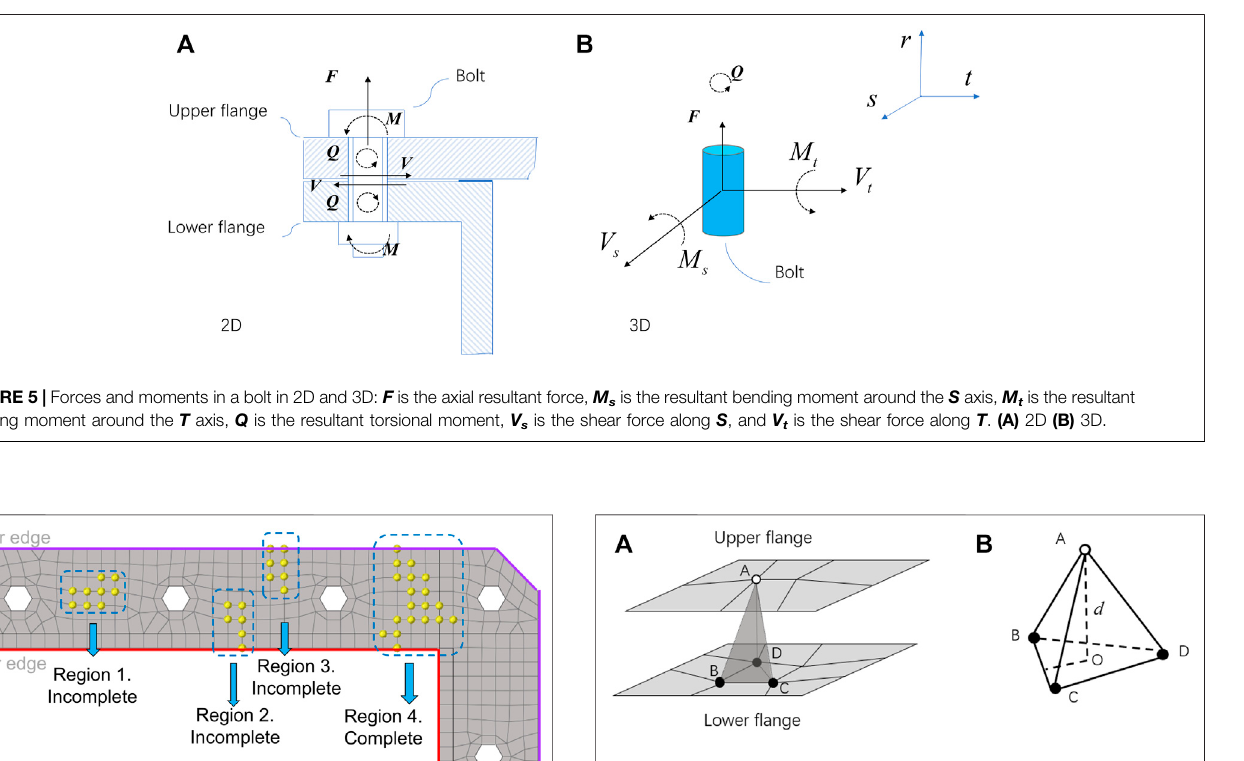
FIGURE 8 | Schematic of the detection technology. (A) neighboring nodes (B) constructed